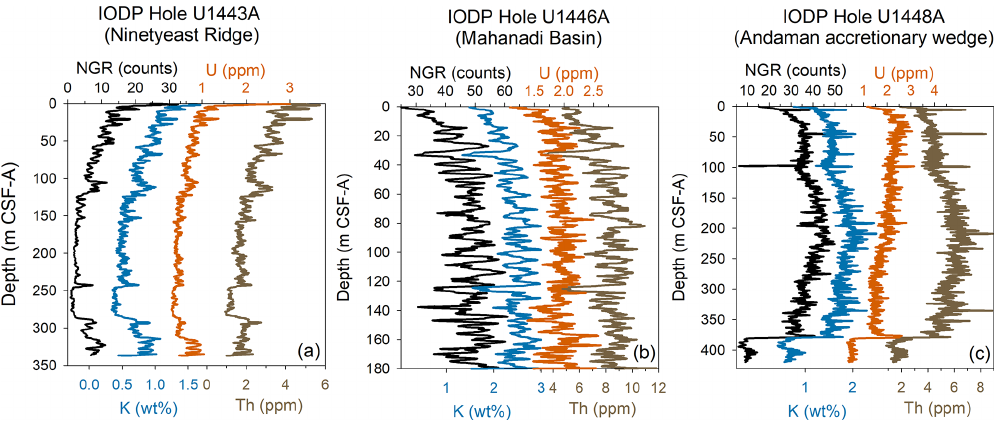
Figure 8. Downcore plots of natural gamma radiation (NGR) and K, U, and Th contents based on NGR spectra (De Vleeschouwer, 2017) from IODP Holes (a) U1443A, (b) U1446A, and (c)